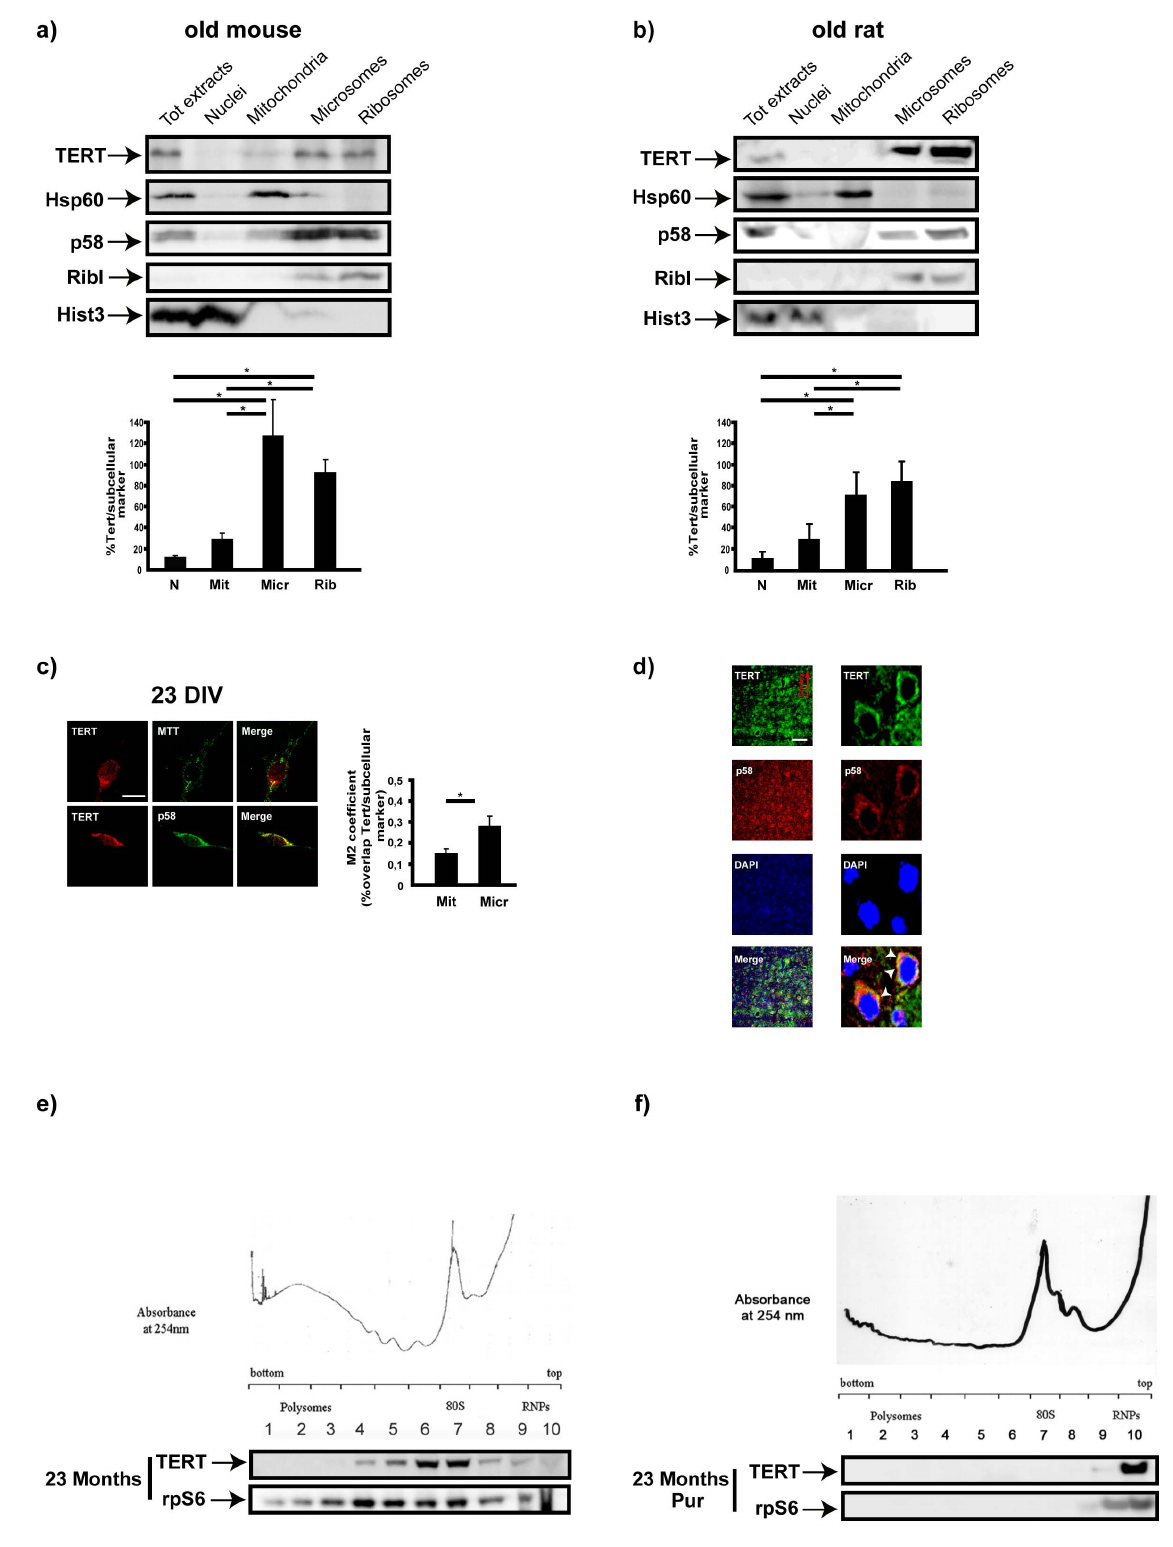
Figure 1. Neuronal TERT is enriched in ribosome-containing compartments invivo. a)-b) Western blot analysis of TERT localization in subcellular fractions from the brains of 23 month-old mice and rats. Hsp60, RibophorinI, p58 and Histone3 are markers of, respectively, mitochondria, ribosomes, microsomes and nuclei. TERT is clearly enriched in the microsome and ribosomal fractions in old mouse brain. Bar graph reflects these differences (mean 6 s.d. of four different mice, mean 6 s.d. of three different rats, *p , 0.05). c) Representative confocal images of 23 DIV hippocampal neurons stained for TERT (red) and counterstained with MTT, mitochondrial selective dye (green) and p58 (green), microsomal marker. Bar: 10 m m. Bar graph on the right: quantification of soluble TERT in mitochondria and microsomal fractions; bars represent the mean 6 s.d. of three